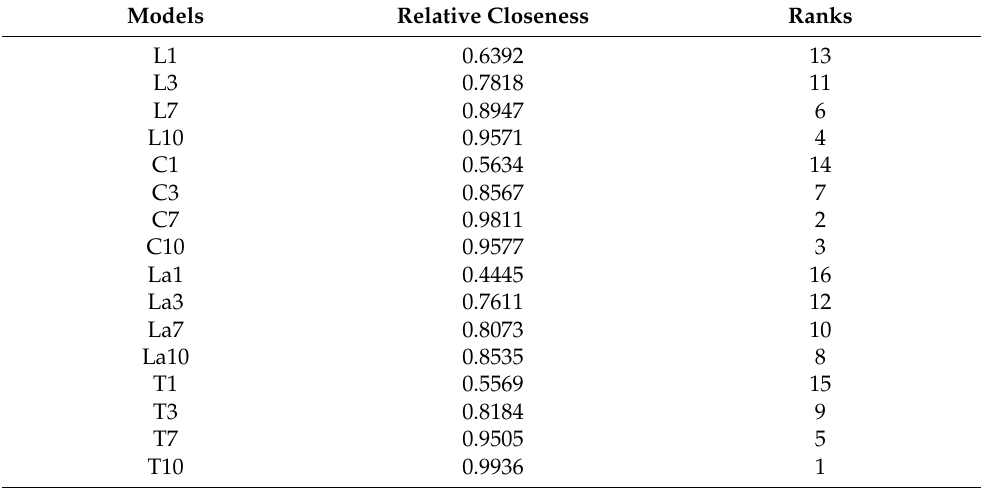
Table 17. Ranking models for Binance